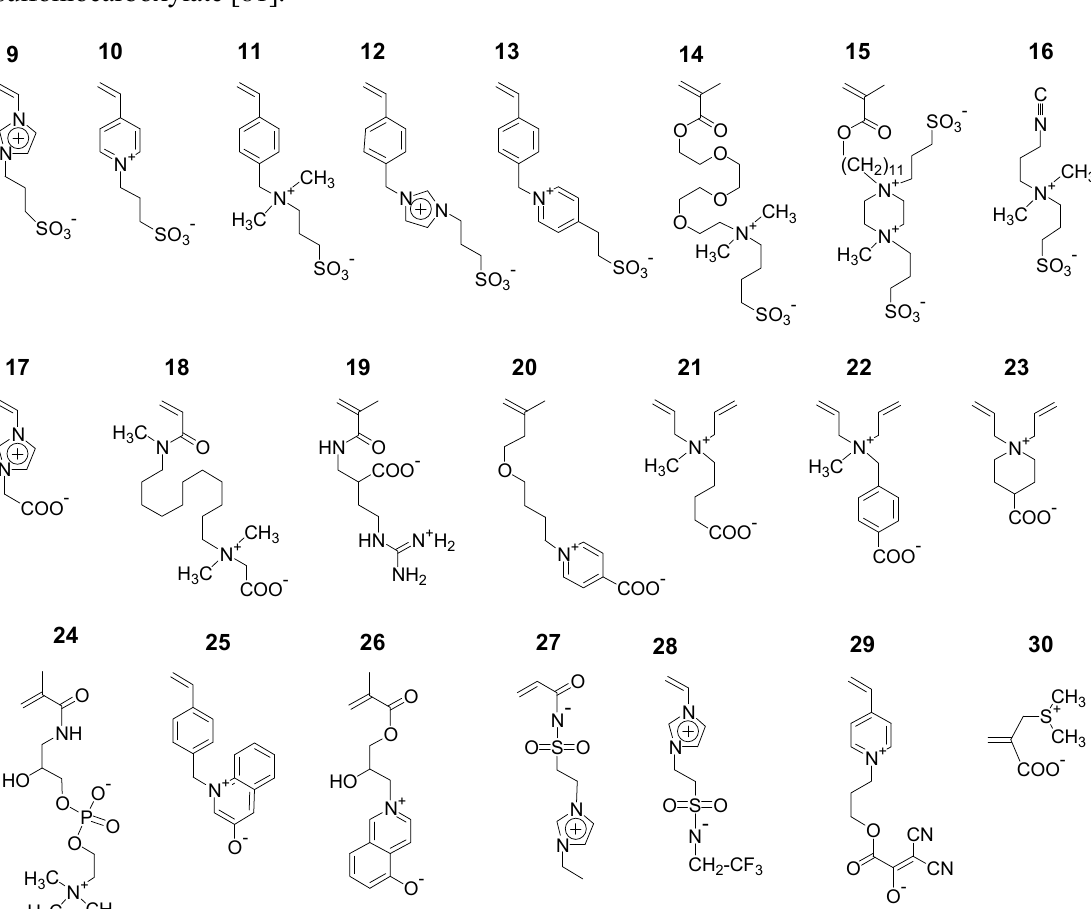
Figure 4. Zwitterionic monomers suited for free radical polymerization, Top row: sulfobetaines based on vinylimidazole [160,161], vinylpyridine